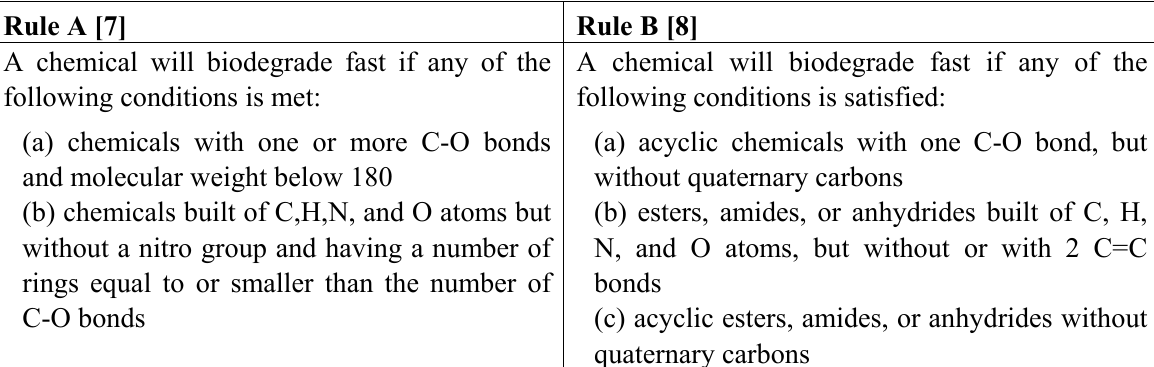
Table 4. Rules developed for inductive machine learning model by Gamberger et al